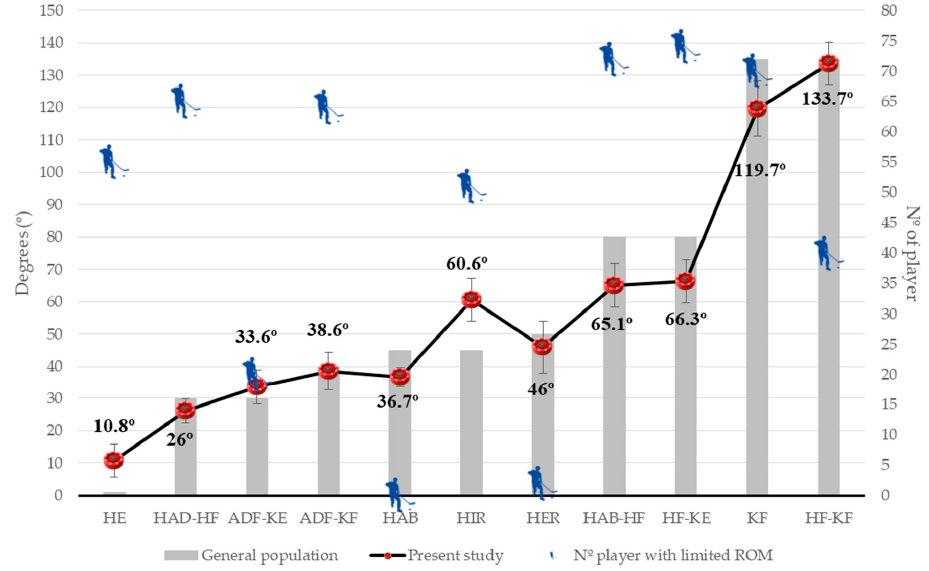
Figure 1. Comparison of lower-extremity flexibility profile in the 74 youth competitive inline hockey players with the general population values [37–40,51] and number of inline hockey players with limited range of motion. Hip extension test; HAD-HF: hip adduction with the hip flexed 90 ◦ extended test; ADF-KE: ankle dorsiflexion with the knee extended test; ADF-KF: ankle dorsiflexion with knee flexed test; HAB: hip abduction test; HIR, hip internal rotation test; HER: hip external rotation test; HAB-HF: hip abduction with the hip flexed 90 ◦ test; HF-KE: hip flexion with the knee extended test; KF: knee flexion test; HF-KF, hip flexion with knee flexed test. Table 3. Range of motion (ROM) classified in normal versus limited categories (mean ± standard deviation) in 74 youth inline hockey players.